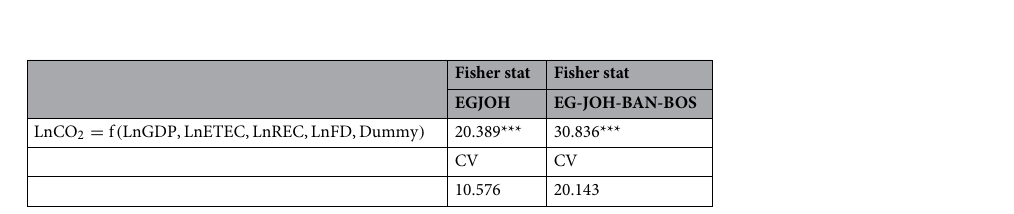
Table 4. Bounds test. ***P < 1%.